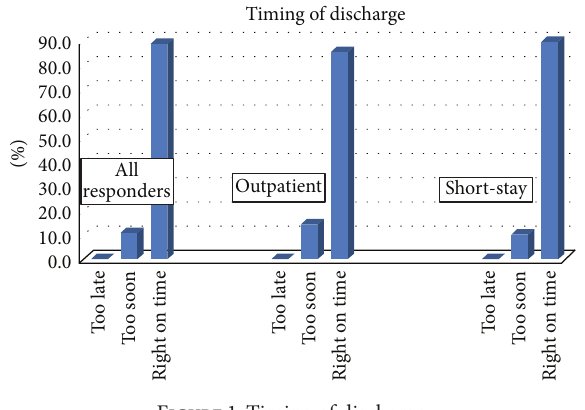
Figure 1: Timing of discharge.